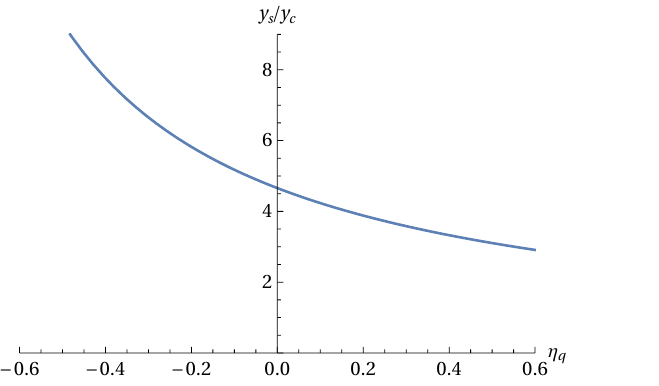
Figure 4 . The values of the ratio y s =y c for the second family as a function of (cid:17) q , assuming